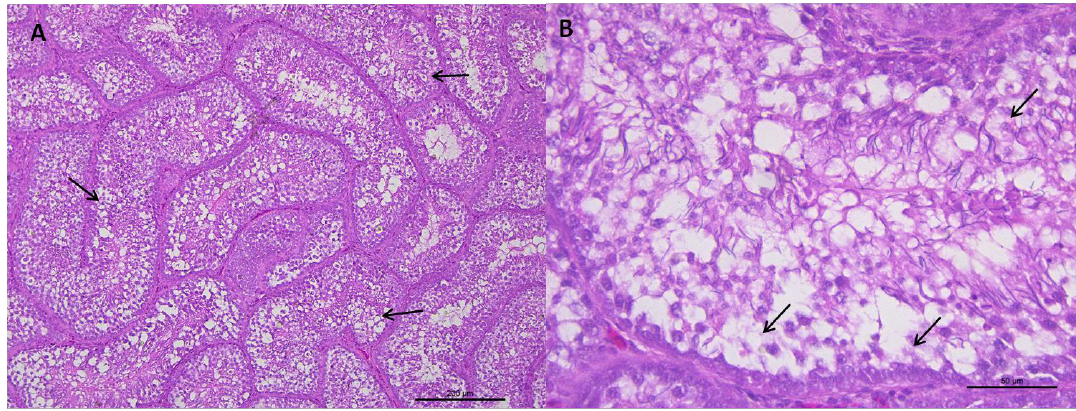
Figure 2. (A) Representative transverse section of seminiferous tubules of roosters from 62 weeks of age with weights below the standard and a value of 1 for testicular integrity. Multifocal vacuoles (arrows) are observed in the epithelium of the seminiferous tubules and a severe depopulation of the spermatic line. HE staining (bar: 200 μm). (B) Area extension of photograph A. Vacuolization and disorganization of the seminiferous tubule epithelium is observed, as well as, cell depopulation of the spermatic line (arrows). HE staining (bar: 50 μm).